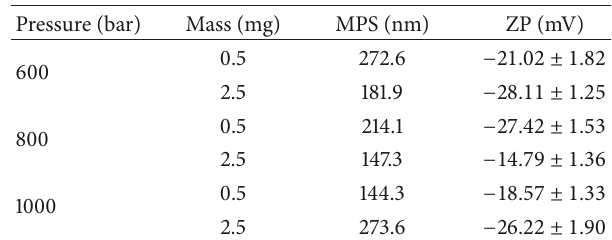
Table 5: Preparation of HCPTNPs with poloxamer 188 by